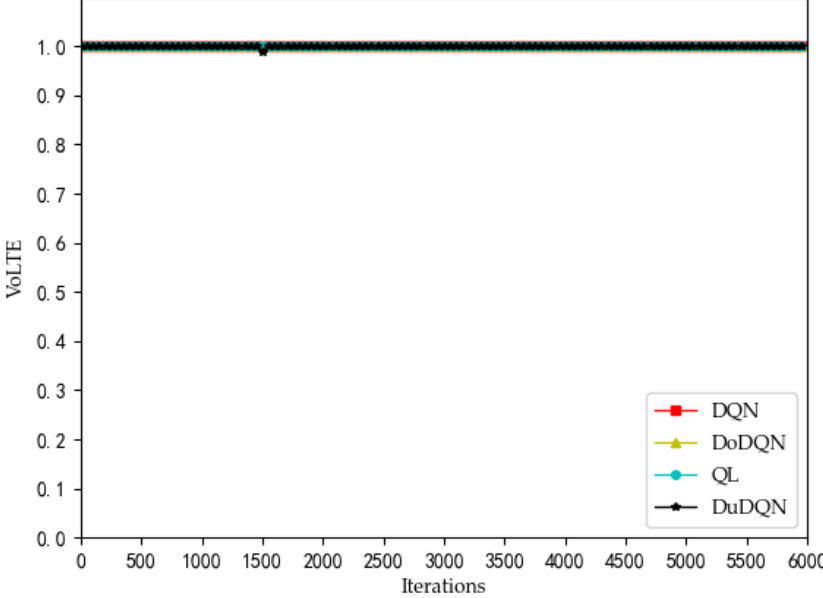
Figure 7. Comparison of QoE of VoLTE using different methods (taking MVNO-1 as examples).